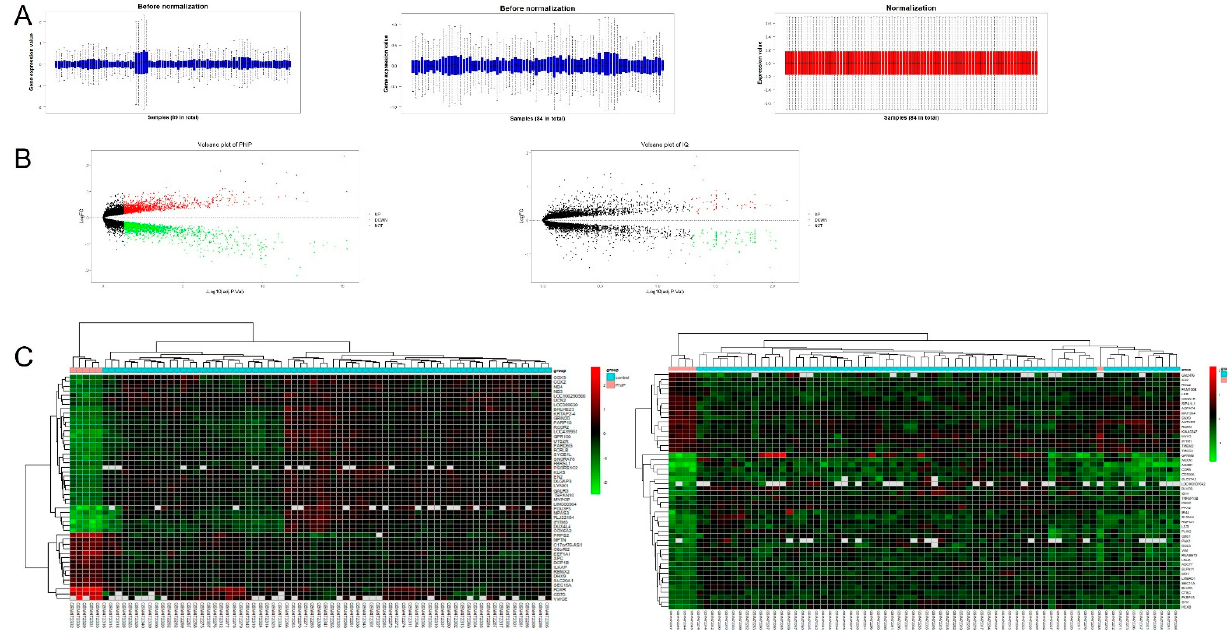
Figure 4. The LIMMA analysis for differentially expressed genes (DEGs) in the PhIP and IQ group. ( A ) The gene expression values of samples in GSE19078. Five samples, “GSM472290” “GSM472291” “GSM472292” “GSM472293” “GSM472294” (deoxynivalenol group) excluded for their high values may not be suitable for linear module analysis. ( B ) the volcano plot of PhIP and IQ, with the adjusted p -value < 0.05 as the thresholds for DEGs. ( C ) The top 50 most differentially expressed genes in the PhIP and IQ group, calculated with the normalized expression value of each